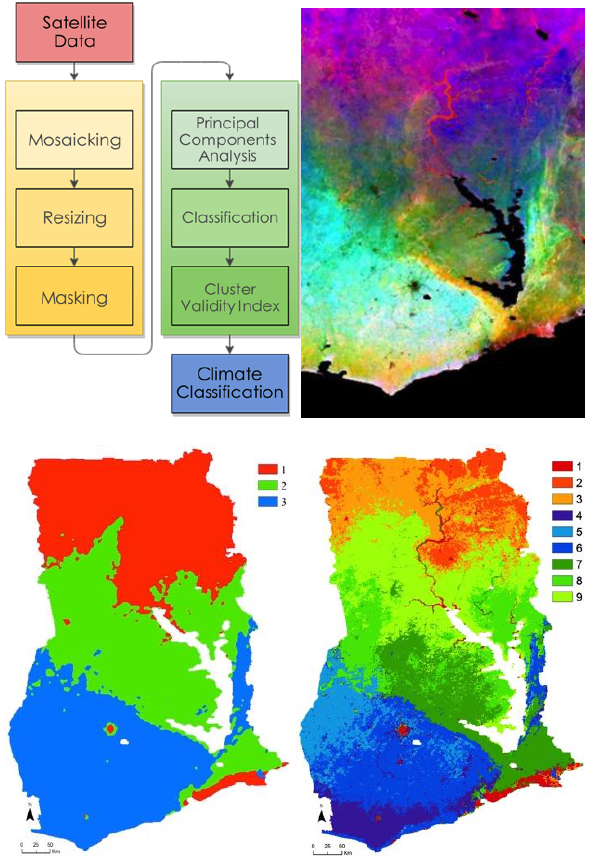
Figure 1: Climate classification workflow. A) flowchart of the LKN method. B) first four components of the PCA.C) 3 major zones and D) 9 minor zones determined by CVI analysis.